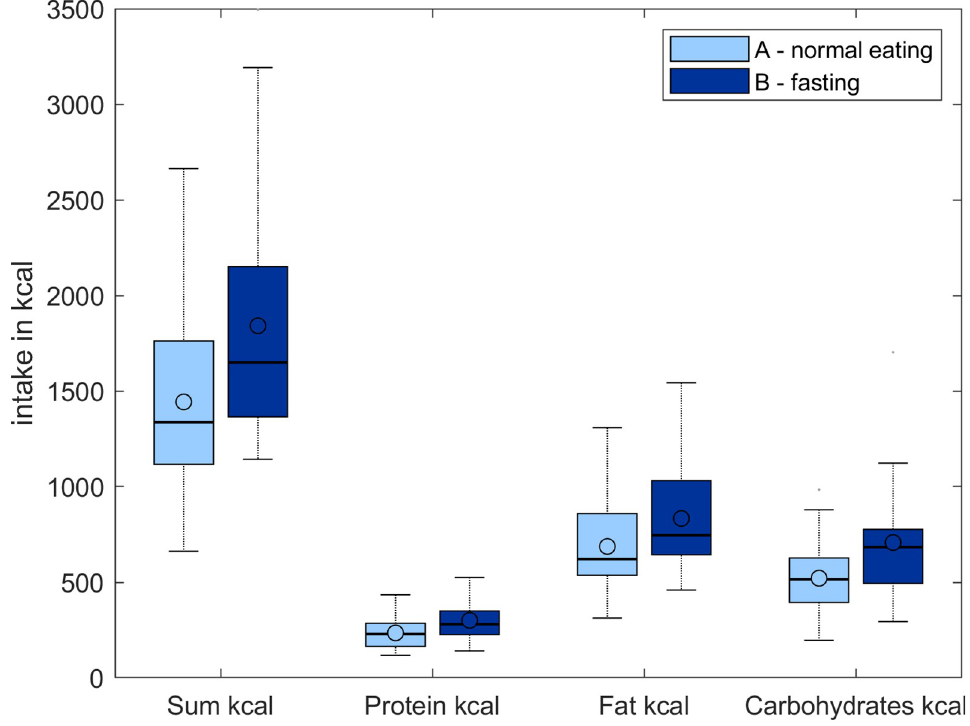
Fig 1. Food consumption during the buffet after 42 hours of fasting and the control condition. Box Plots of the total food consumption in the buffet scenario for both fasting and normal eating condition. The total amount of kilocalories and the overall amount of each macronutrient consumed differed significantly between the